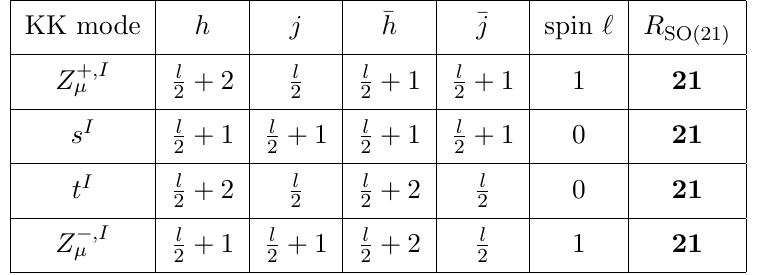
, l = (cid:0) 1 ; 0 ; 1 ; : : : l